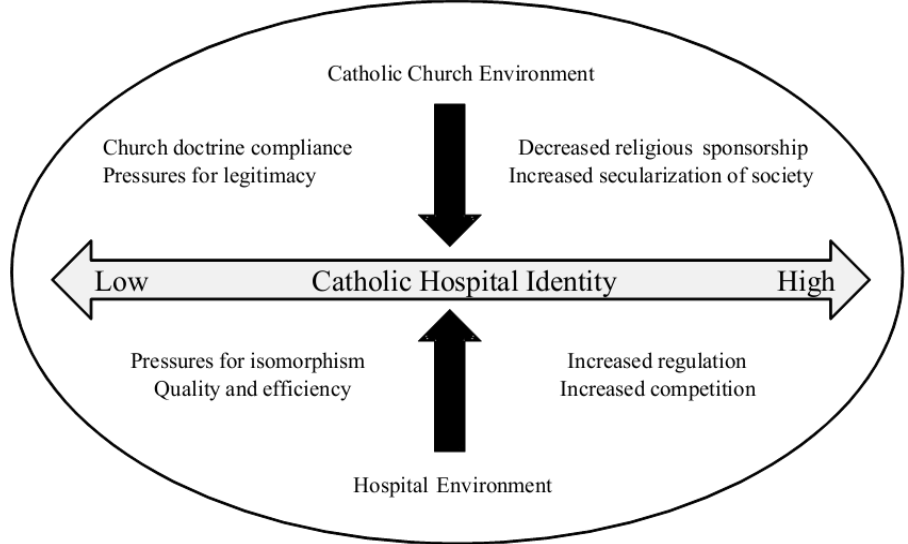
Figure 1. The Impact of Catholic Church and Hospital Environments on Catholic Hospital